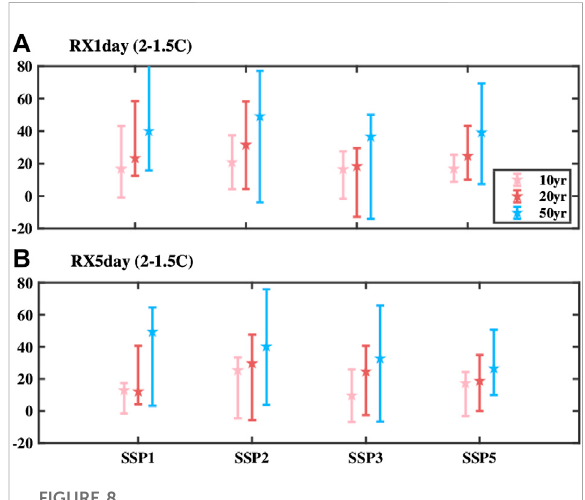
FIGURE 8 The regional mean reduced population exposure to 10-year, 20-year and 50-year (A) RX1day and (B) RX5day under the 1.5 ° C warmer climate instead of the 2.0 ° C warmer climate. The star points and error bars represent the MMEs and interquartile model spreads, respectively. Units: